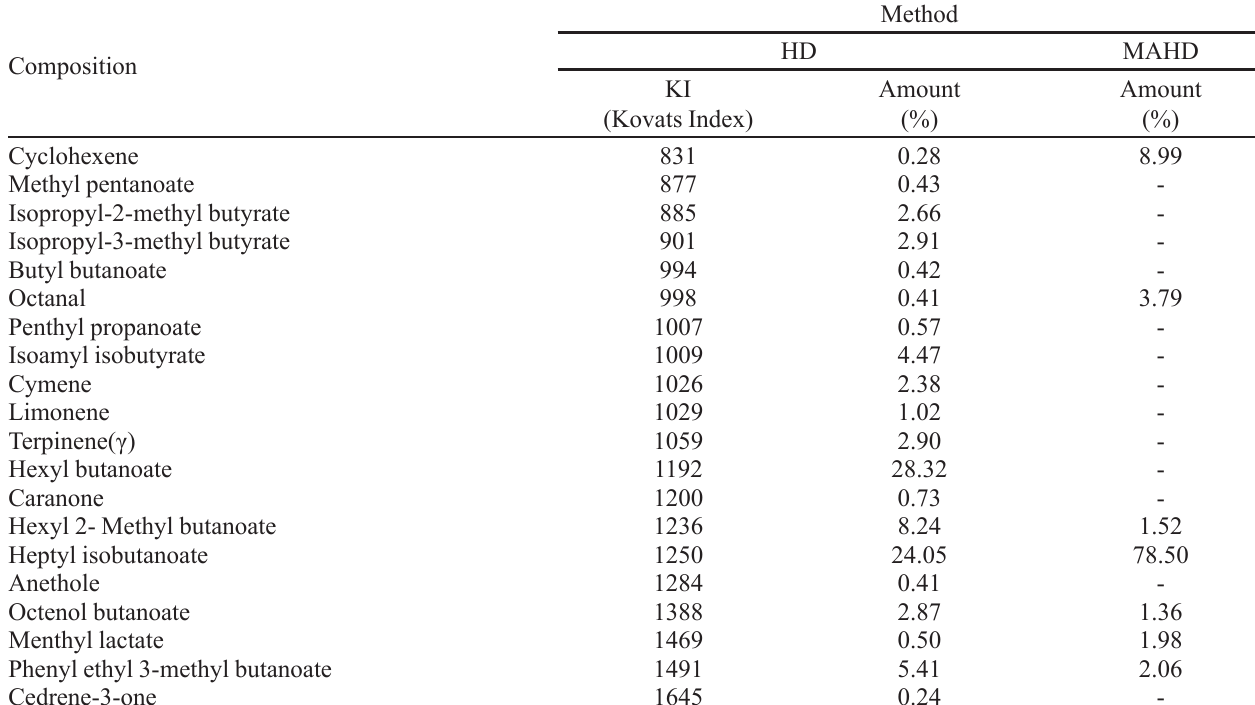
TABLE I - Chemical compositions of Heracleum persicum essential oils extracted by MAHD and HD methods